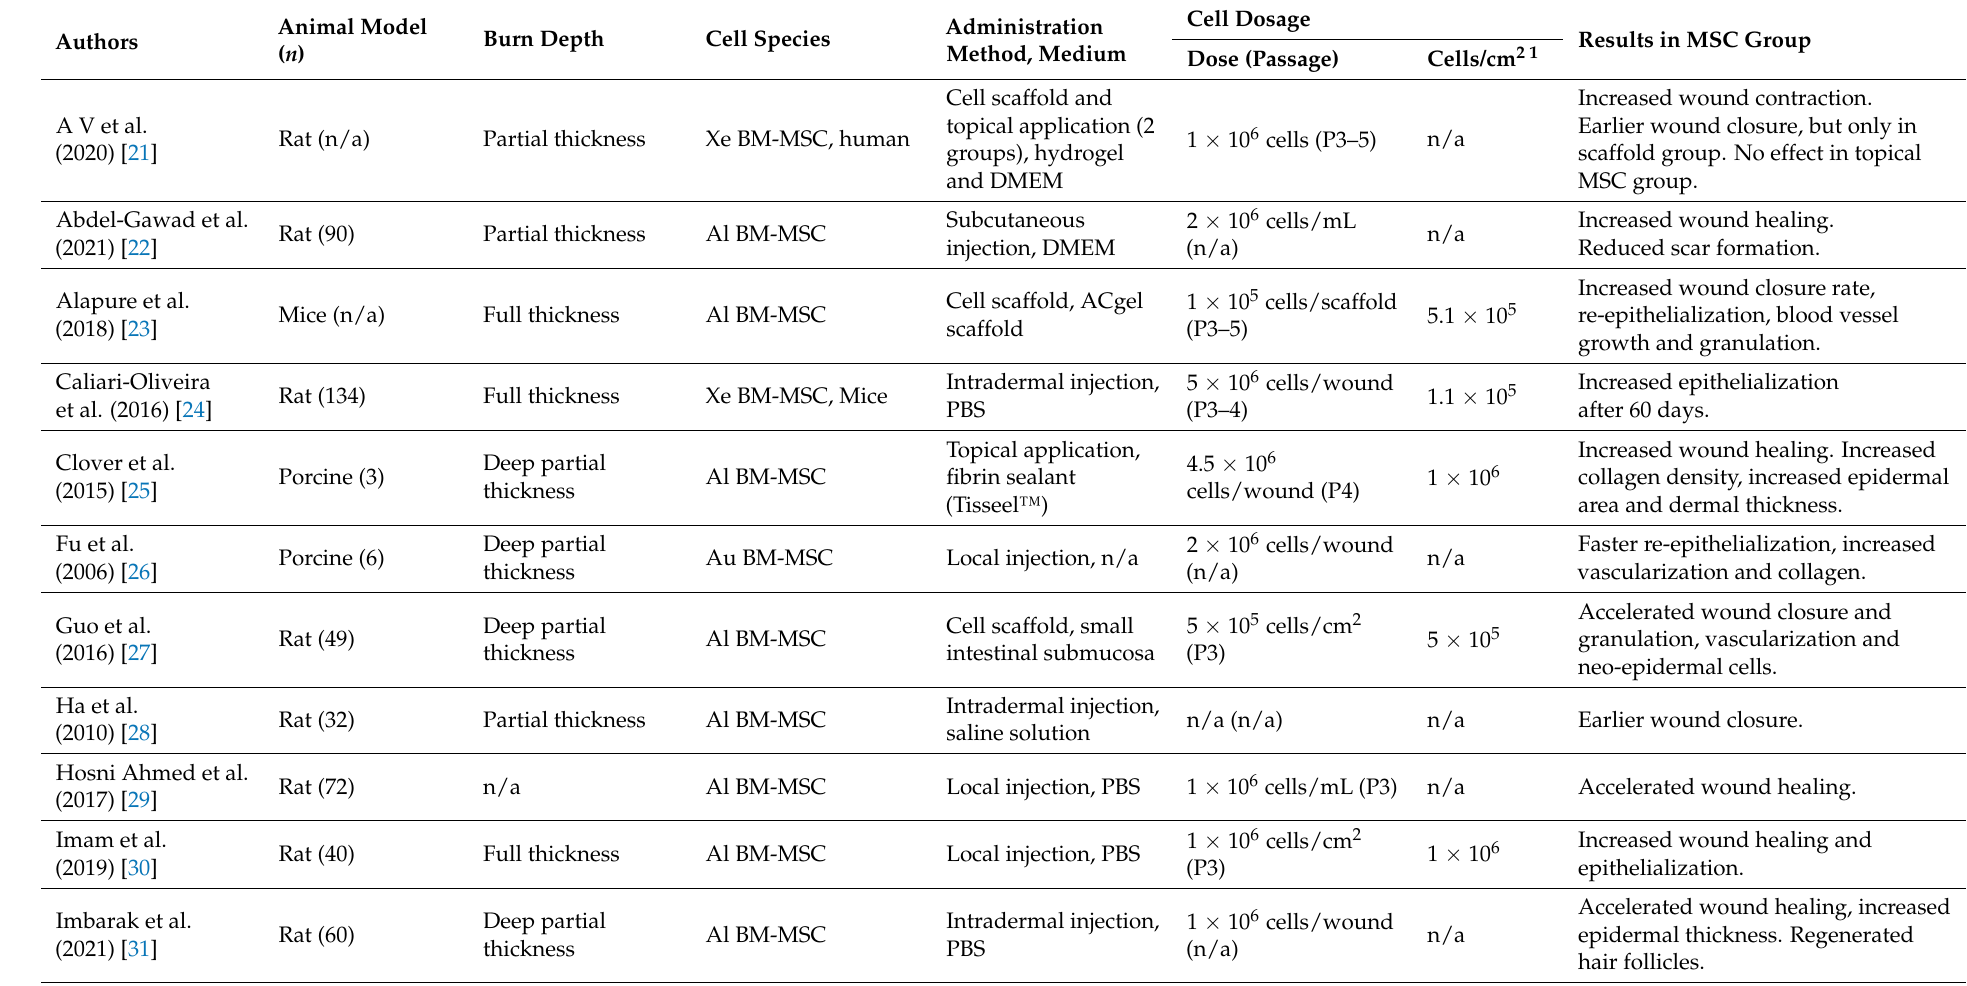
Table 3. Characteristics of studies included—preclinical studies using bone-marrow-derived MSCs ( n =